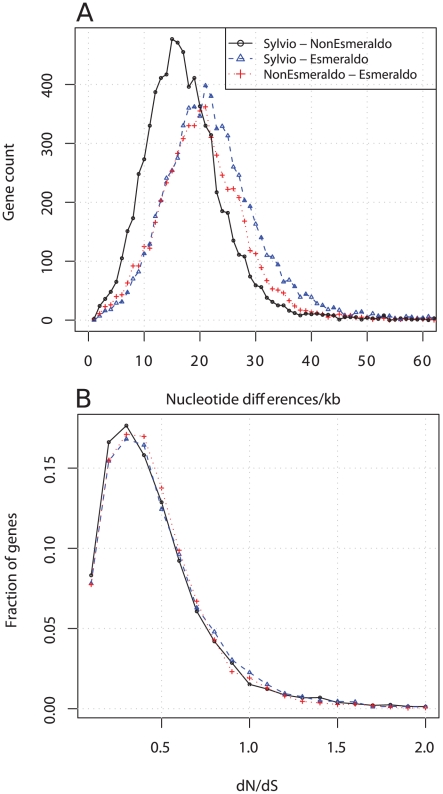
Nucleotide differences and dN/dS estimations.Black lines (circles) represent Sylvio X10/1 compared to non-Esmeraldo, blue lines (triangles) represent Sylvio X10/1 compared to Esmeraldo and red lines (crosses) represent non-Esmeraldo compared to Esmeraldo. A) Shows the distribution of single nucleotide differences (ND) in genes, normalized to show the number of ND per 1000 bp. Sylvio X10/1-Esmeraldo show the largest number of ND, and have 25 ND/kb/gene in average. B) Shows the ratios of non-synonymous and synonymous nucleotide variation (horizontal axis shows dN/dS) between the comparisons as a fraction of the genes examined (vertical axis). All comparisons have average dN/dS around 0.40 and the shape of the curves has a similar appearance. About 95% of the examined genes have a ratio below 1, implying that the genes are under purifying selection and 336 genes show evidence of positive selection (dN/dS >1).